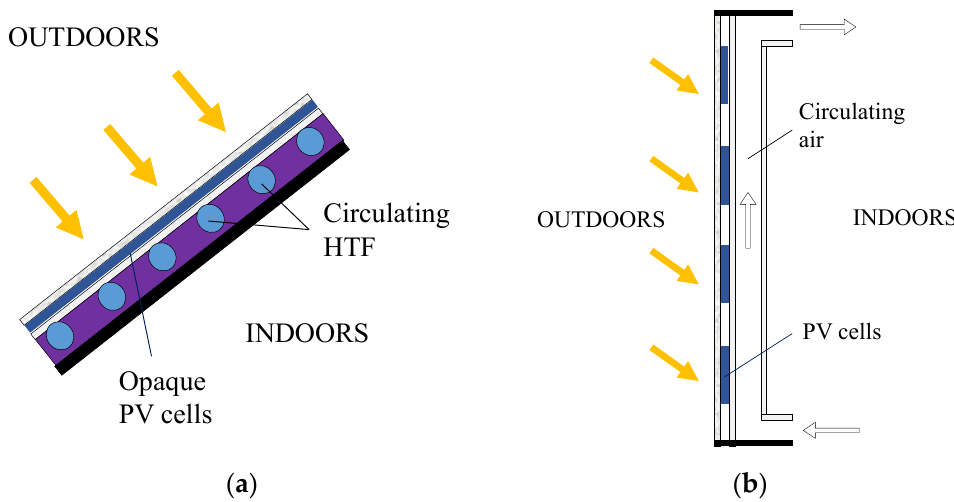
Figure 5. Two main types of BIPV-T collectors: ( a ) roof-integrated BIPV-T collector (opaque) and ( b ) semi-transparent BIPV-T collector (semi-transparent window).